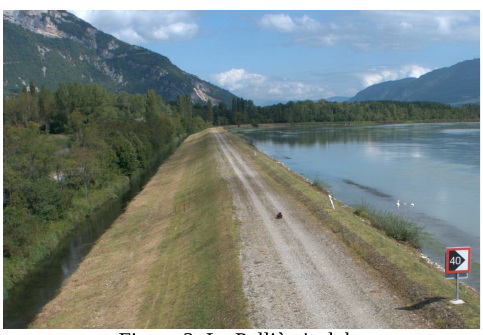
Figure 2: La Pallière's dyke